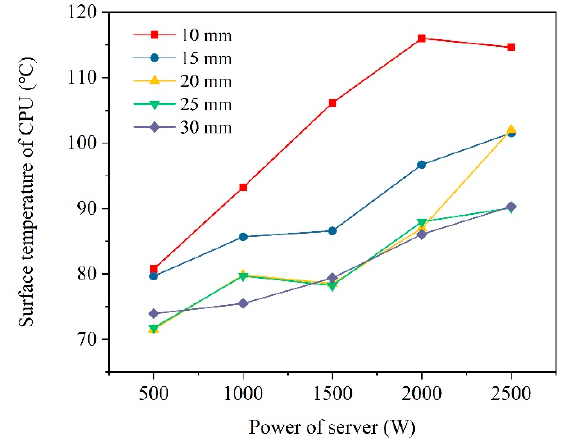
Figure 11. Correlation between the server’s power and the average CPU temperature.